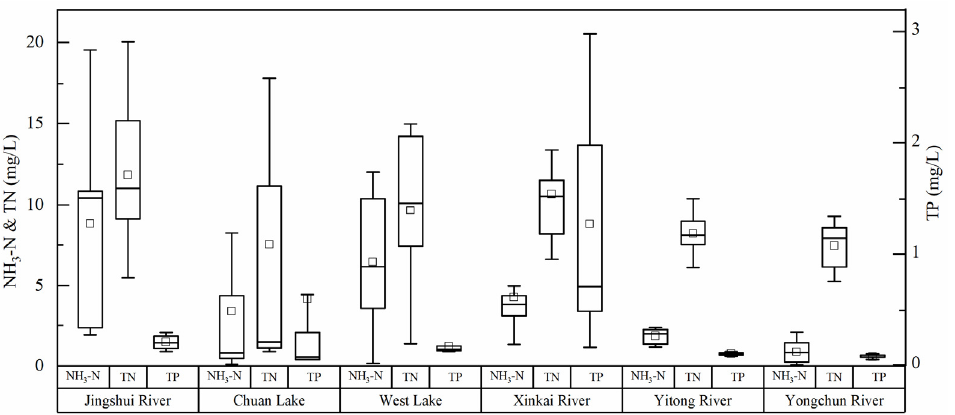
Figure 2. The content of ammonia nitrogen (NH 3 -N), total nitrogen (TN), and total phosphorus (TP) in the overlying water of six rivers in Changchun City.